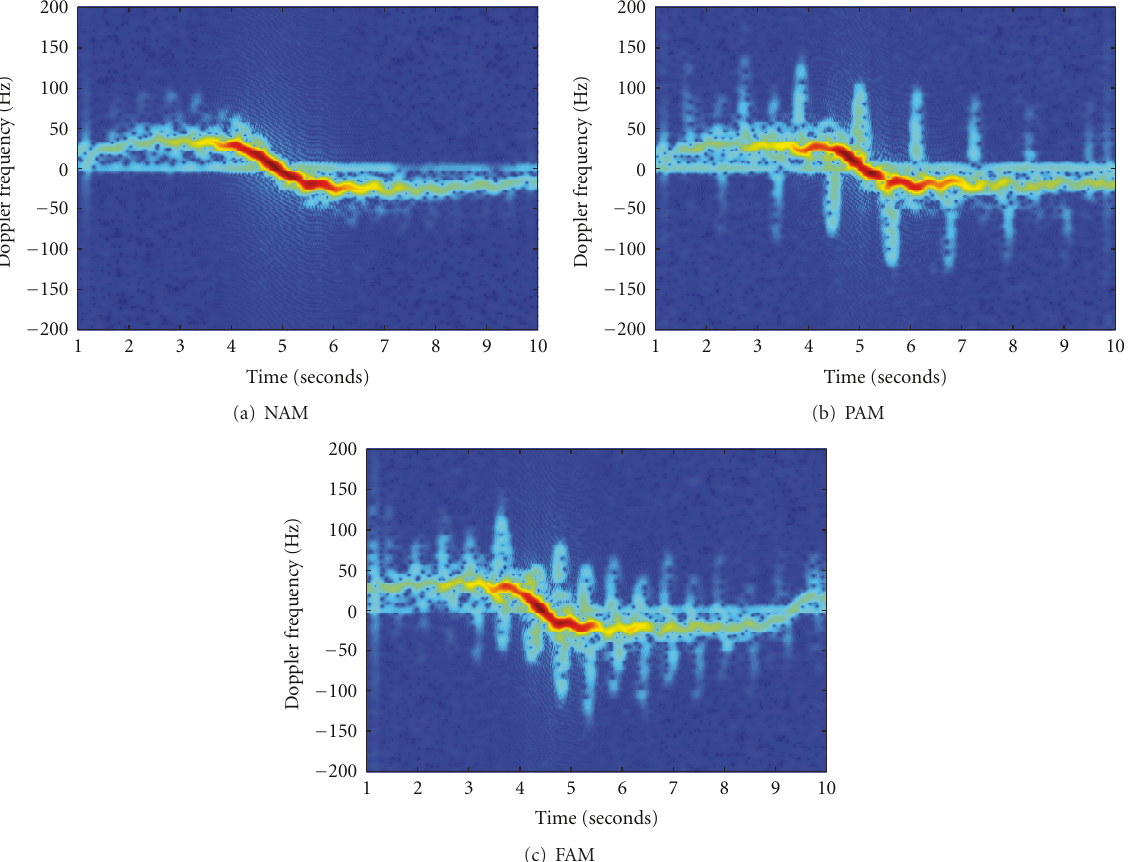
Figure 1: Spectrograms of three human arm motions for the first 10 sec of the recorded signal: (a) no-arm swing, (b) one-arm swing and (c) two-arm